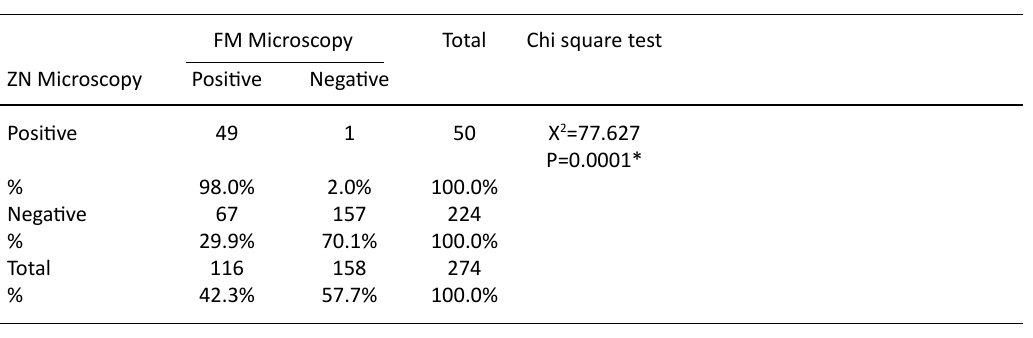
Table 3. Comparison of ZN & FM stain